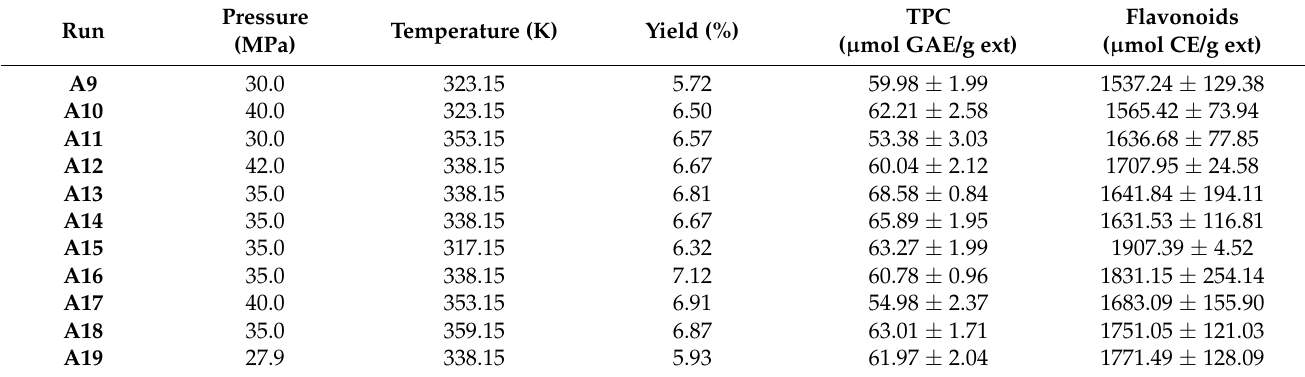
Table 2. CCD test design results and the response evaluated in each run